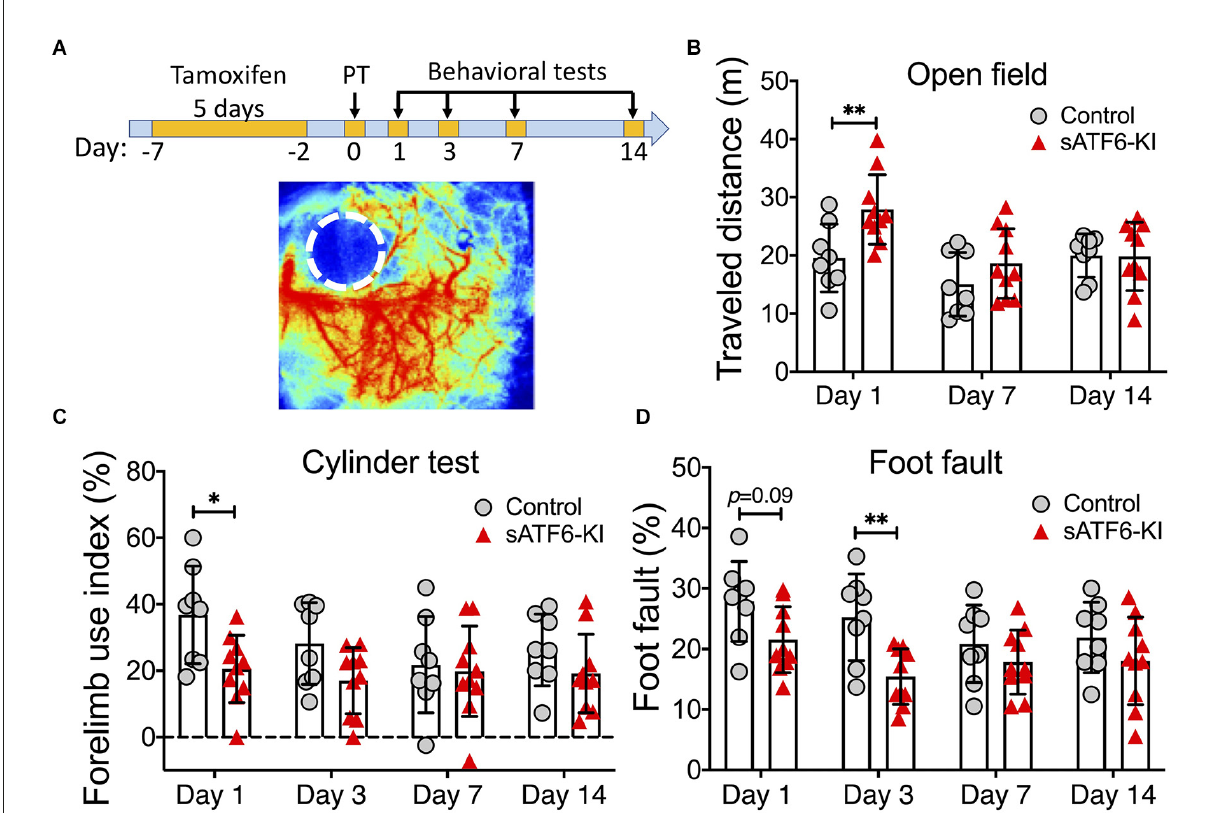
FIGURE1 Activation of the ATF6 pathway in neurons improved short-term but not long-term outcome after photothrombotic stroke. (A) Experimental design. A representative laser speckle contrast image of PT stroke brain is shown below. (B–D) Functional outcome. sATF6-KI ( n = 10) and littermate control ( n = 8) mice were subjected to photothrombotic (PT) stroke. Behavioral tests, including open field (B) , cylinder (C) , and foot fault (D) tests, were performed over 14 days after PT stroke. Data are presented as mean ± SD. ∗ p < 0.05; ∗∗ p < 0.01.